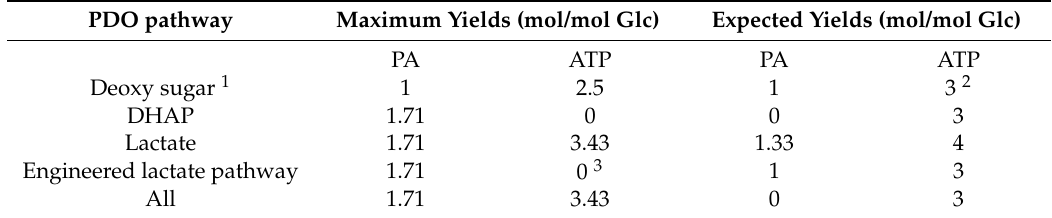
Table 4. Estimated yields for propionate and ATP production in propanediol fermentative pathways. PDO pathway Maximum Yields (mol/mol Glc) Expected Yields (mol/mol Glc) PA ATP PA ATP Deoxy sugar